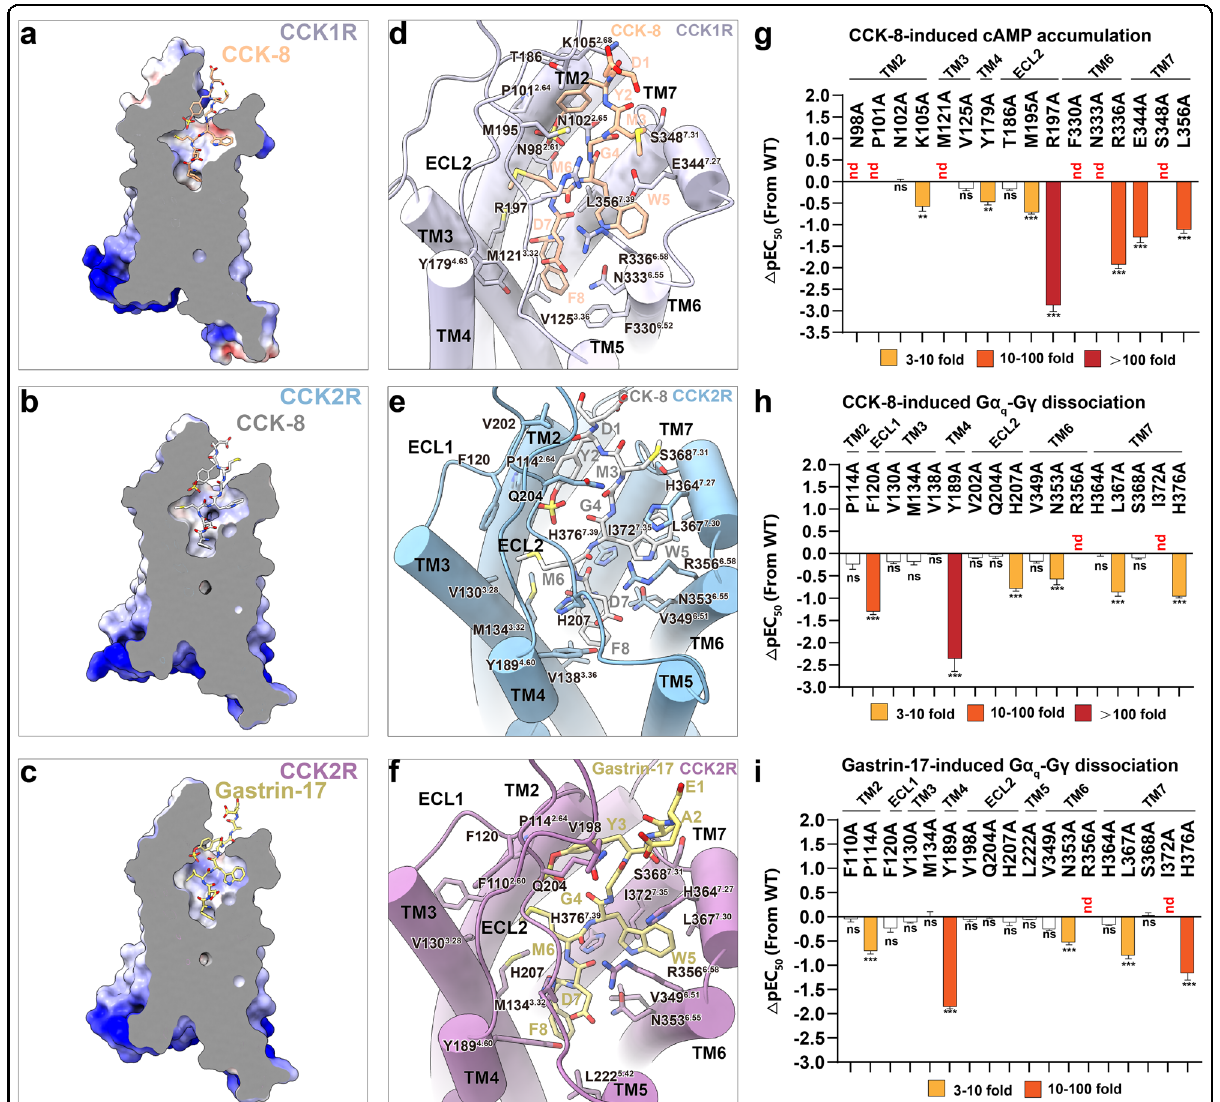
Fig. 2 Endogenous ligand recognition of CCK1R and CCK2R. a – c Electrostatic potential map of CCK-8-binding pocket in CCK1R ( a ), CCK2R ( b ), and gastrin-binding pocket in CCK2R ( c ). d – f Detailed interactions between CCK-8 (sienna) and CCK1R (light slate blue) ( d ); between CCK-8 (gray) and CCK2R (blue) ( e ); between gastrin-17 (yellow) and CCK2R (purple) ( f ). g Mutagenesis analysis of residues involved in CCK-8 binding using CCK-8- induced cAMP accumulation assay. h Mutagenesis analysis of residues involved in CCK-8 binding using CCK-8-induced G α q – G γ dissociation assay. i Mutagenesis analysis of residues involved in gastrin-17 binding using gastrin-17-induced G α q – G γ dissociation assay. Bars represent differences in calculated potency (pEC 50 ) for representative mutants relative to the wild-type receptor (WT). Data were colored according to the extent of effect (orange, 3 – 10-fold reduction of EC 50 ; tomato, 10 – 100-fold reduction of EC 50 ; red, > 100-fold reduction of EC 50 ). ns, no signi fi cance; ** P < 0.001, *** P < 0.0001 (one-way ANOVA followed by Dunnett ’ s post hoc test, compared with response of WT). nd, pEC 50 change went beyond the detection